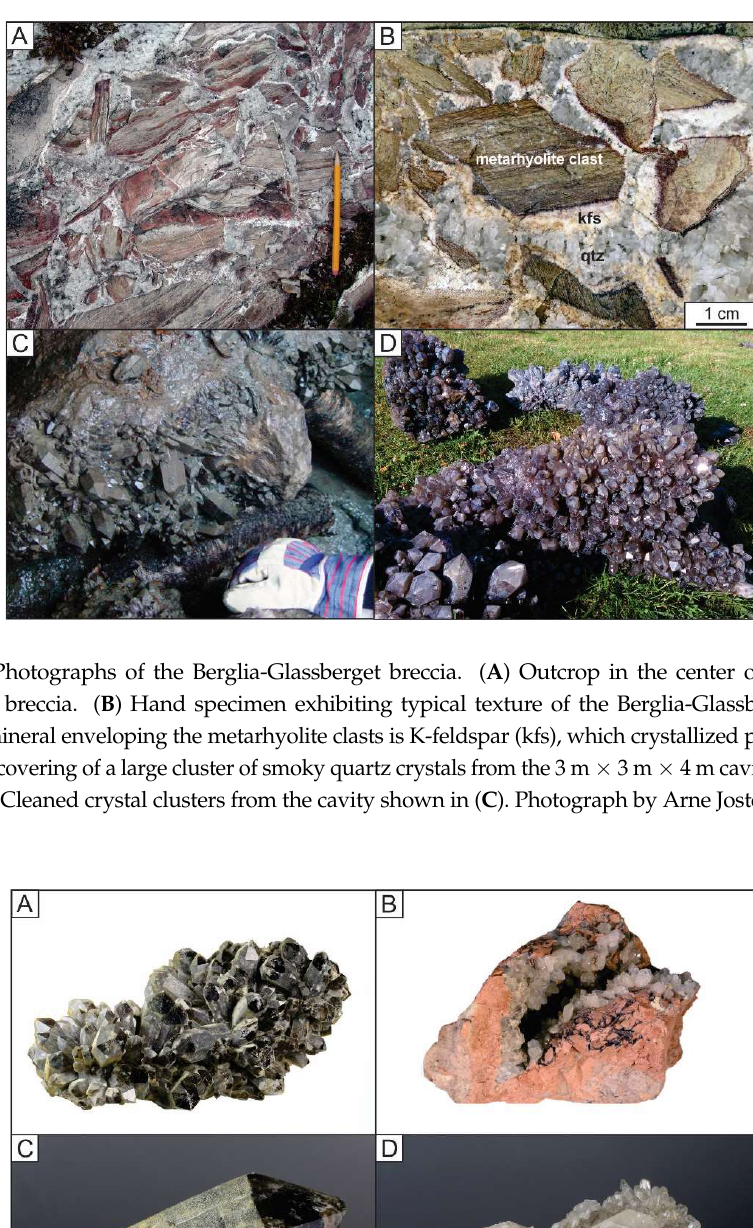
Figure 4. Photographs of minerals related to the Berglia-Glassberget breccia. ( A ) Cluster of smoky quartz crystals. The length of the specimen, which was donated by Arne Jostein Devik to the Natural History Museum of Oslo, is 30 cm (NHM collection nr. 41919). Photograph by Øivind Thorensen. ( B ) Small cavity with flesh-coloured adularia crystals overgrown by quartz crystals. Length of specimen 10 cm. ( C ) 14 cm long, smoky quartz crystal donated by Arne Jostein Devik to the Natural History